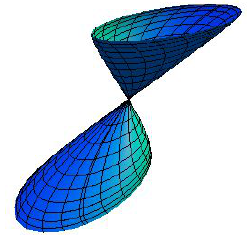
Figure 2. M 2 + with r ( s ) = sin s